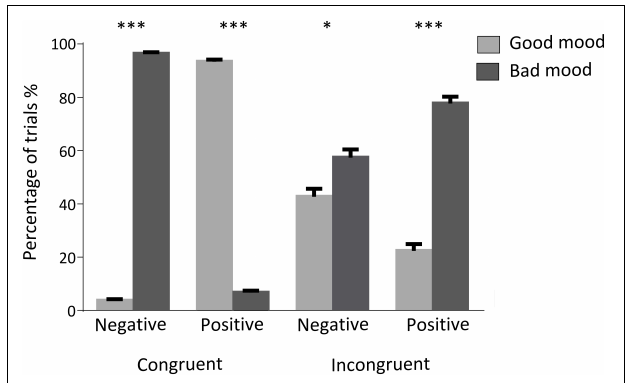
FIGURE 3 | Percentage of trials judged as good or bad mood. Bars indicates the mean and SEM of the percentage of trials judged as good or bad mood for each condition. ‘Negative’ and ‘Positive’ indicates the emoticon’s valence. ∗ , ∗∗∗ : statistically significant differences with p values < 0.05, or < 0.001, respectively.